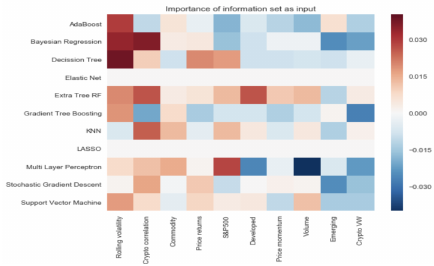
Figure 13: Relative importance of different information sets on predicting 30-day Bitcoin